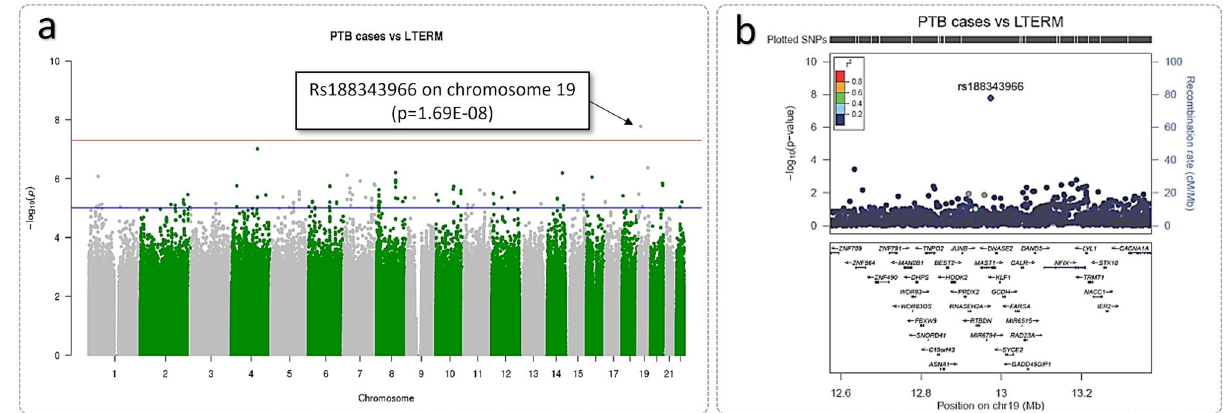
Figure 4. Genome-wide significant SNP identified from PTB cases and LTERM controls GWAS analysis. ( a ) Manhattan plot of all PTB cases (n = 48) ≤ 34 weeks gestation and LTERM (n = 160) ≥ 39 weeks gestation GWAS analysis using Frequentist association test. Multi-dimensional scaling components 1 to 6 of the cohort were included as covariates. The upper red horizontal line displays the genome-wide significance threshold (p < 5 × 10 –8 ) and the lower blue horizontal line represents an arbitrary suggestive threshold (p < 1 × 10 –5 ). One SNP (rs188343966) exceeded genome-wide significance in this analysis on chromosome 19 (p = 1.69E−08). Figure generated using R package ‘qqman’ 28 . ( b ) Regional plot of rs188343966 signal. Figure produced using LocusZoom 29